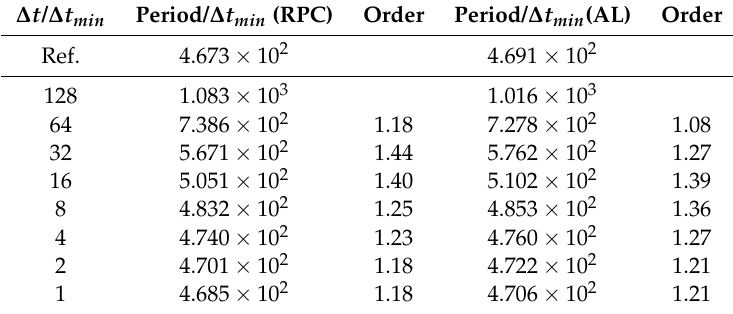
Table 9. Period of the oscillations with the rotational pressure-correction (RPC) and the augmented Lagrangian (AL) with a Gear 2 temporal scheme for the flow past a cylinder at Re = 100. ∆ t / ∆ t